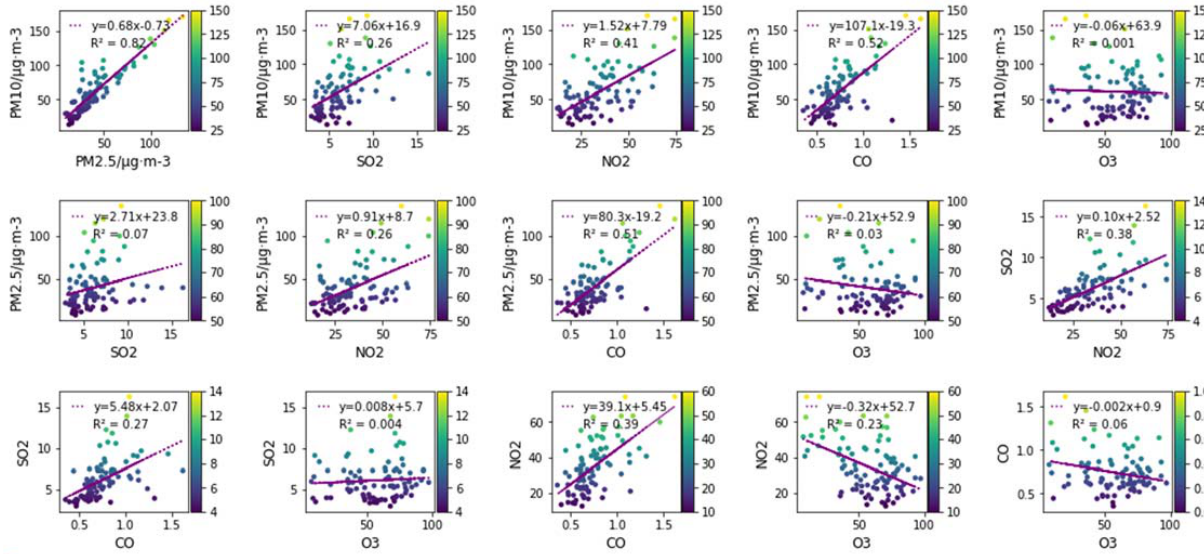
Figure 4. Correlation between different air pollutants.